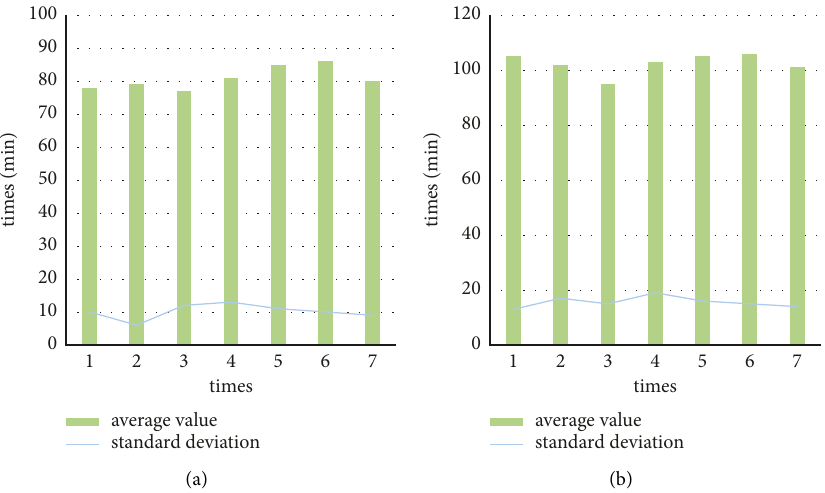
Figure 6: Comparison of heart rate changes before and after training. (a) Change trend of heart rate before training in weeks 10–12. (b) Change trend of heart rate after training in weeks 10–12.